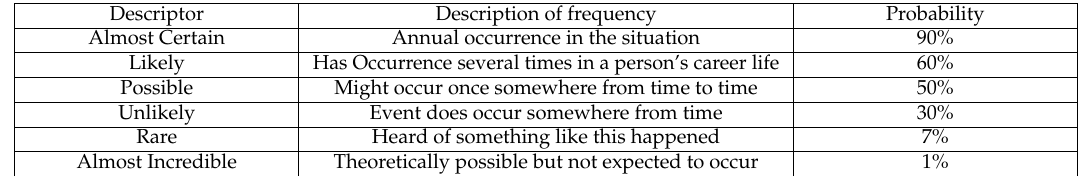
Figure 10. WEP-likelihood scale